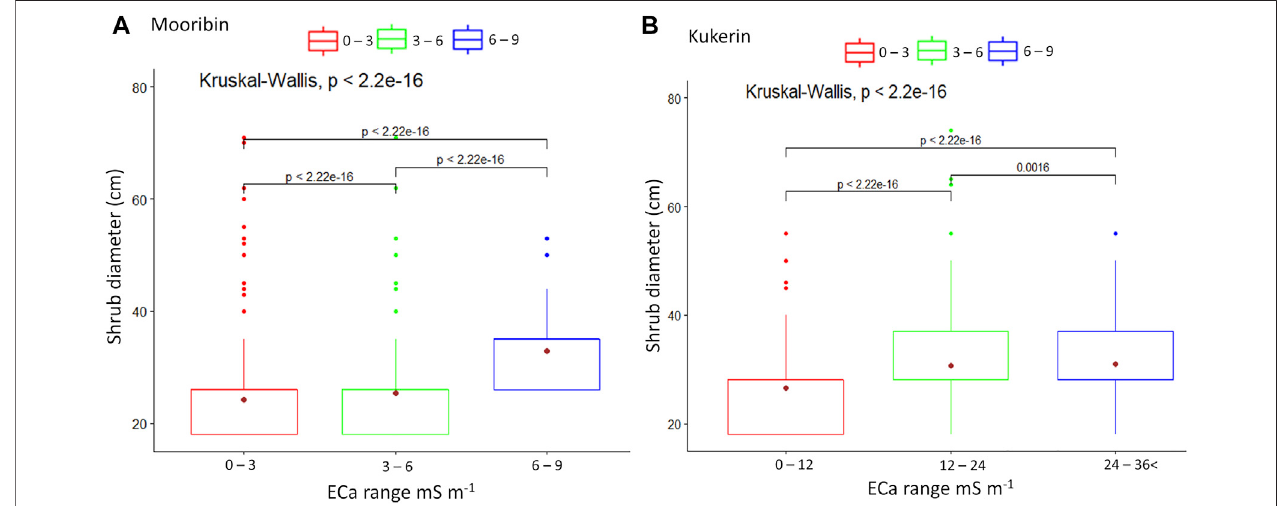
FIGURE8| Kruskal – Walliscomparison ofshrubcanopy diameter(cm)(based onUAV-derived MLmethod)acrossthesiteswiththreedifferentinverted ECranges measured at 0.5 – 0.8 m soil depth ( Figures 2B and K ) at Mooribin (A) and at Kukerin (B) . Whiskers indicate the maximum and minimum values at the 95% con fi dence level, the top and bottom of the box show the 25th and 75th percentiles, and the dot inside is the mean value.